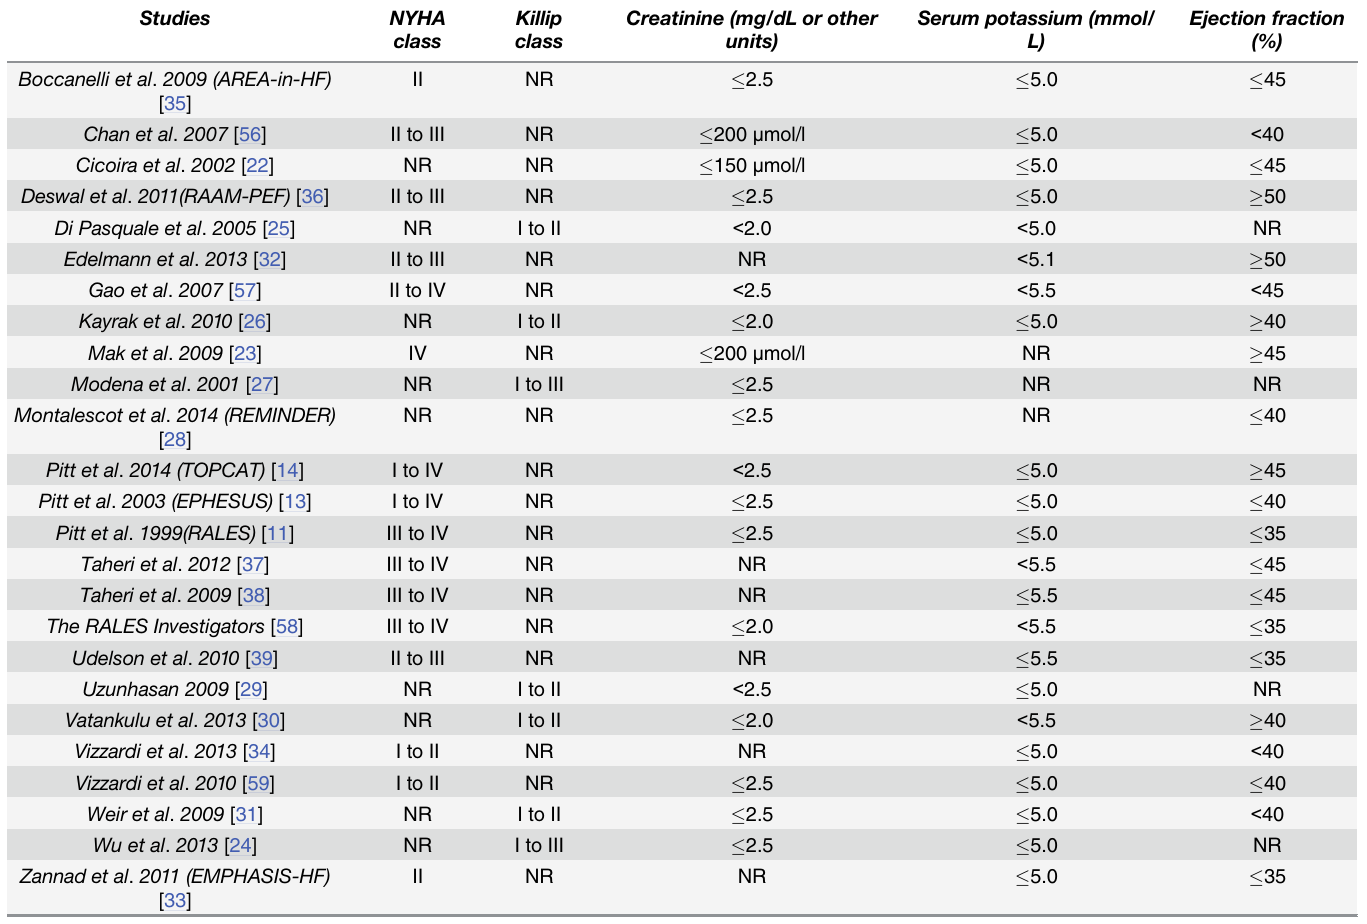
Table 2. Main criteria for patients ’ eligibility in the included studies.